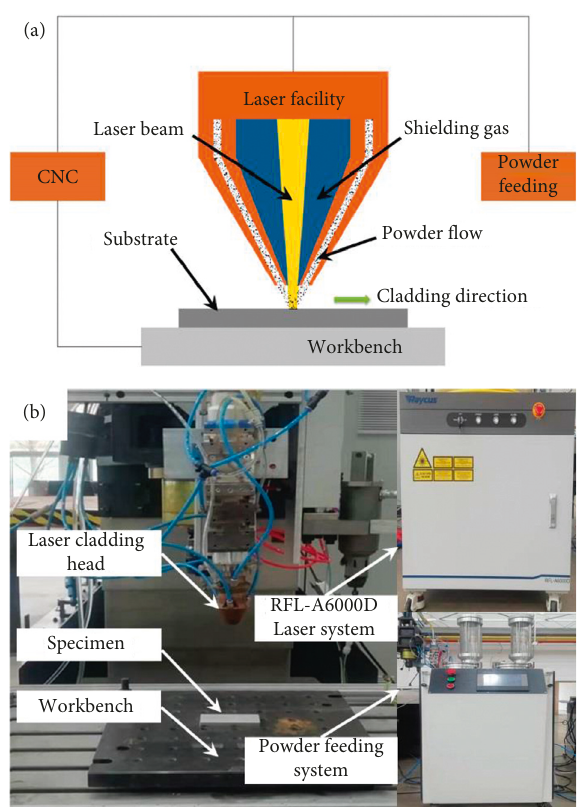
Figure 1: (a) A schematic of the laser cladding system; (b) images of the laser cladding